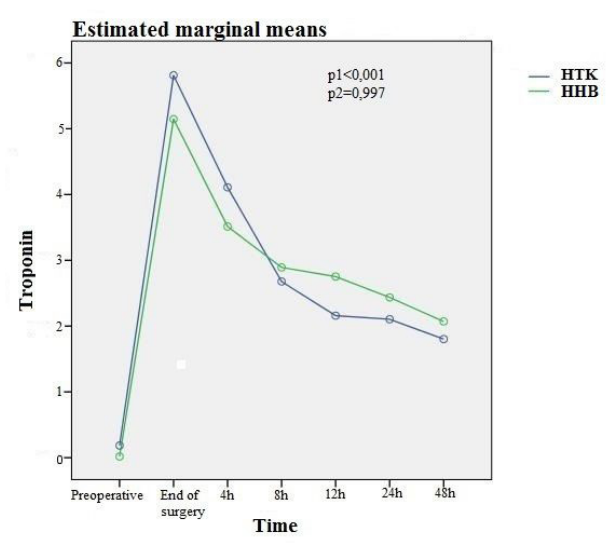
Fig. 2 – Variation of creatine kinase-MB (CK-MB) in time (P1) and between groups